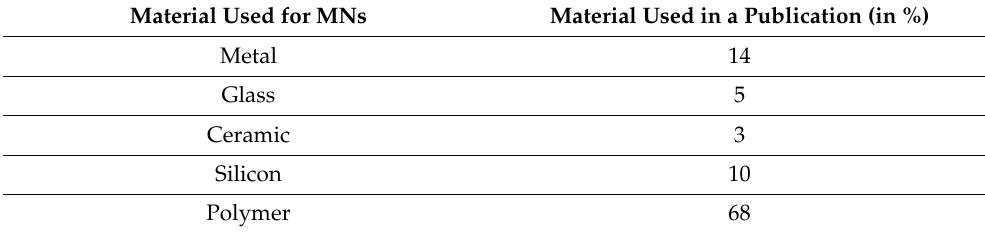
Table 2. Material used for fabrication